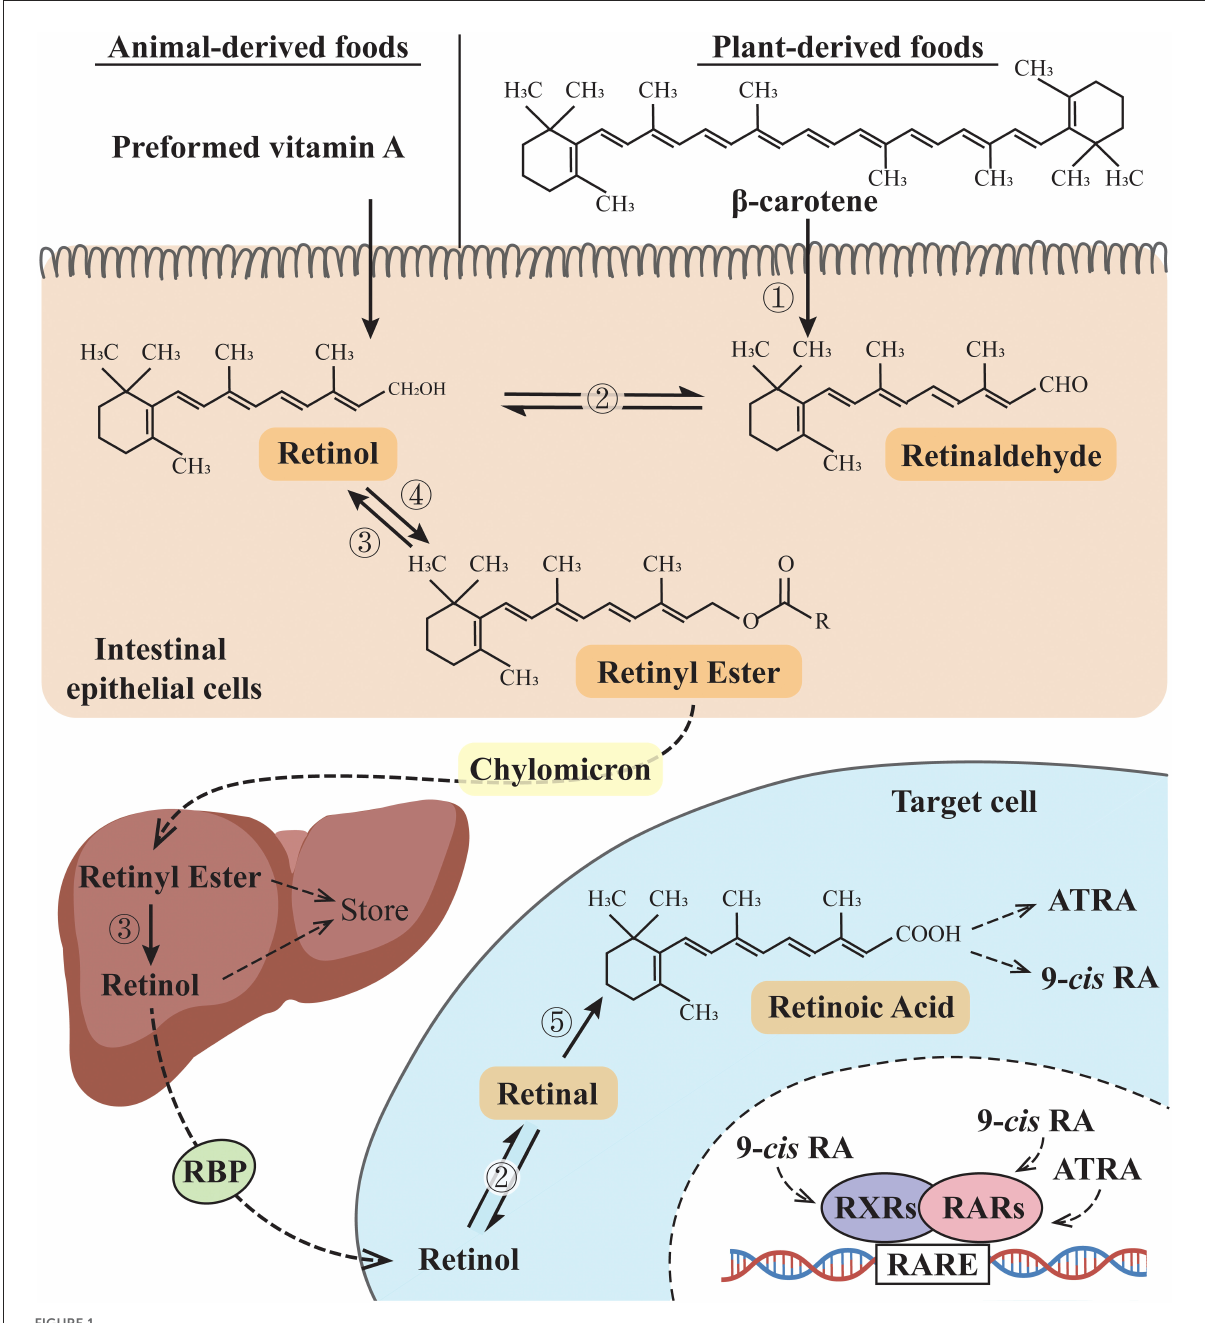
FIGURE1 Vitamin A metabolic pathway. ‹ β -Carotene 15,15’-dioxygenases; › Retinol dehydrogenases (RDHs): RDH1, RDH10, and short-chain dehydrogenase/reductase (SDR family) member 9 (DHRS9) (reversible reaction); fi retinyl esterase; fl lecithin: retinol acyltransferase (LRAT) or acyl-CoA: retinol acyltransferase (ARAT); (cid:176) retinaldehyde dehydrogenases (RALDH). RBP, retinol-binding protein; 9- cis RA: 9- cis retinoic acid; ATRA, all- trans retinoic acid; RXRs, retinoid X receptors; RARs, retinoic acid receptors; RARE, retinoic acid response elements.